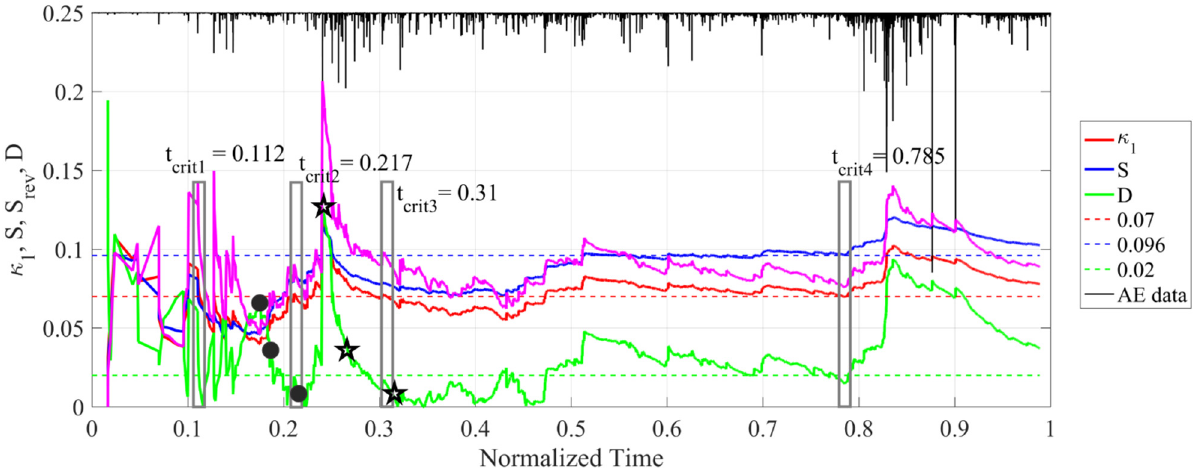
Figure 11. Natural time analysis of the AE events during the three-point bending test on the GFRP plate considering Q k = E AE , k